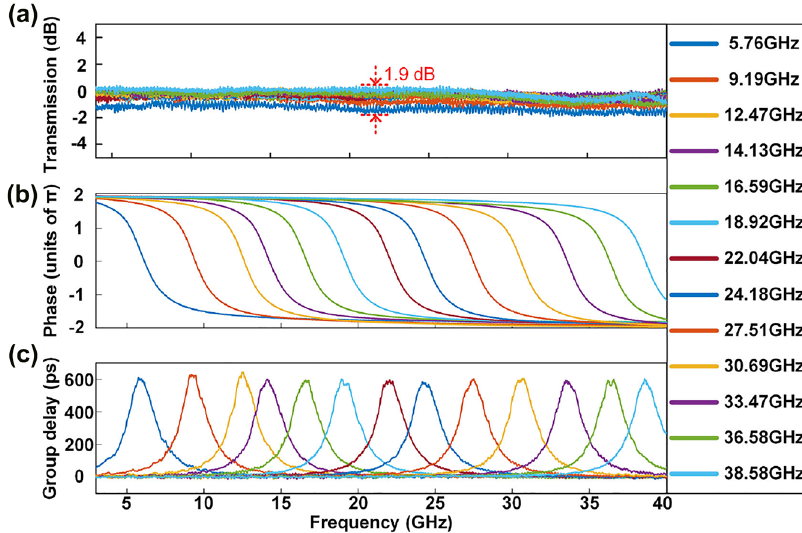
Figure 6: Experimental results of tuning the second-order APF from 5.7 to 38.6